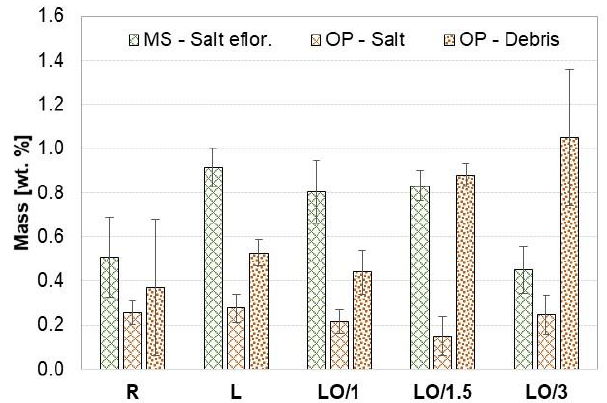
Figure 7. Mass of salt and debris brushed from the surface of Mšen é (MS) and Opuka (OP) stones at the end of the drying test with NaCl solution. Note: only salt efflorescence formed on the surface of the Mšen é stone. Opuka showed delamination of the paint layer and stone caused by cryptoefflorescence.